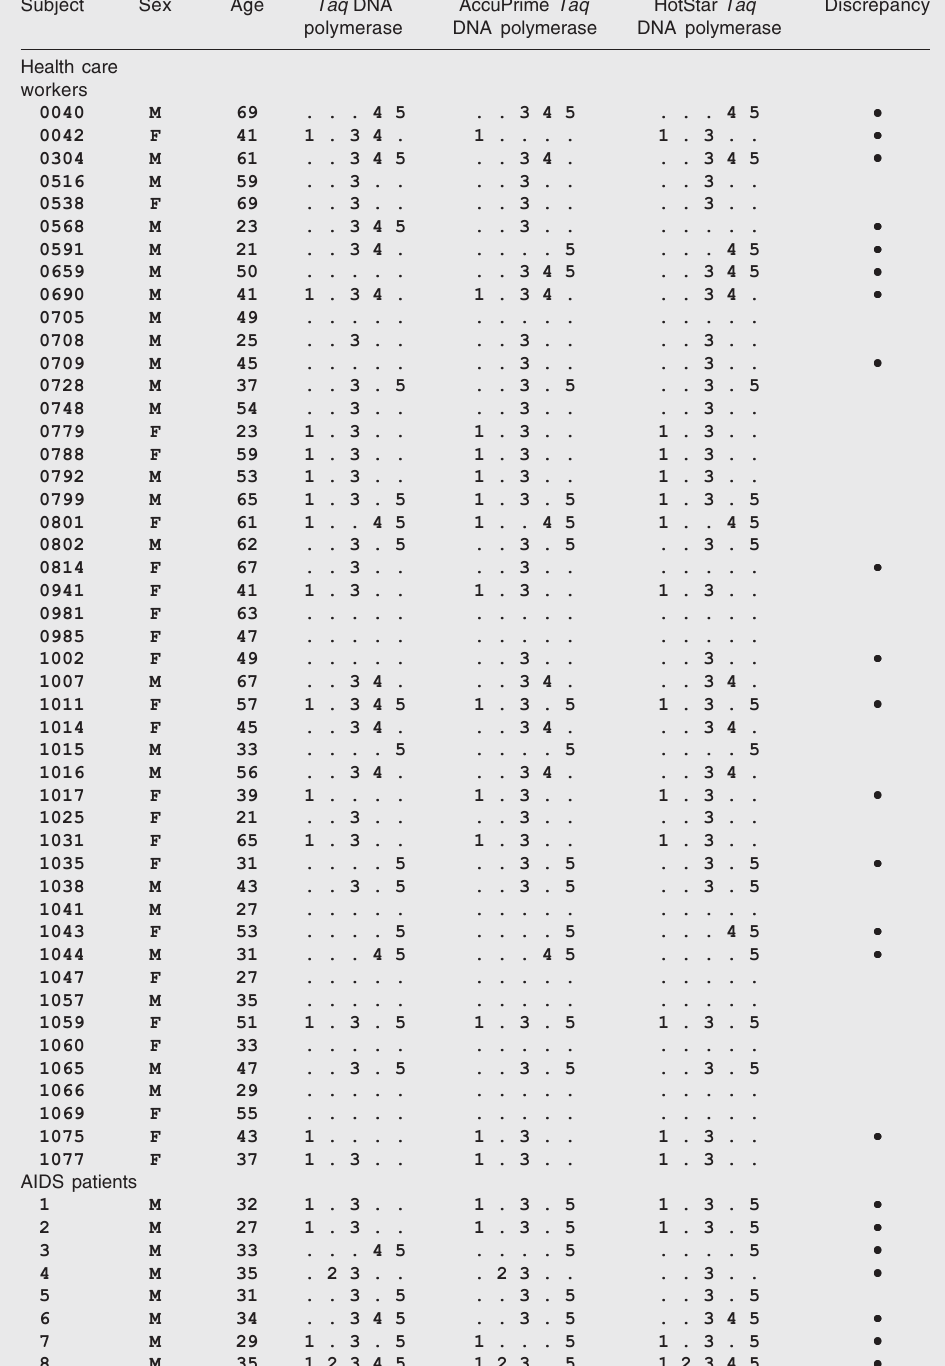
Table 1. Detection of Torque teno virus genomic groups 1 to 5 by multiplex PCR in sera of health care workers and AIDS patients.